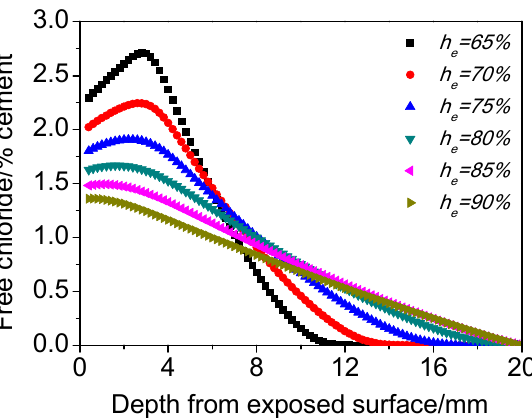
Figure 7. Influence of h i on the chloride distribution of concrete subjected to cyclic wetting and drying conditions.